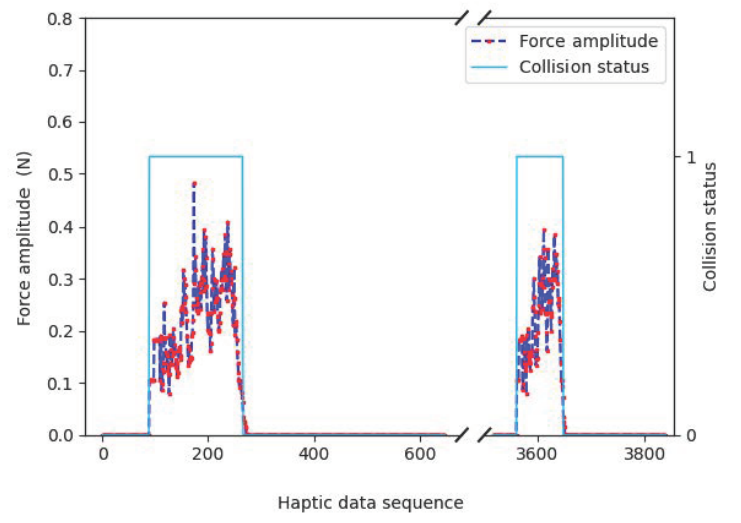
Figure 2. An example of haptic–visual correlations.